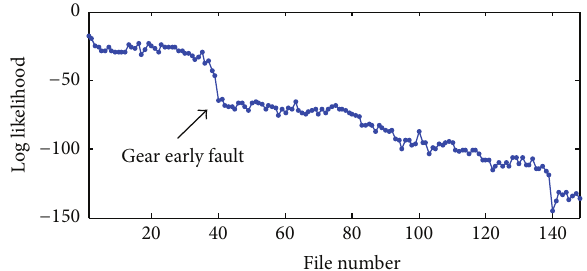
Figure 4: Gear performance degradation assessment using pre- sented architecture